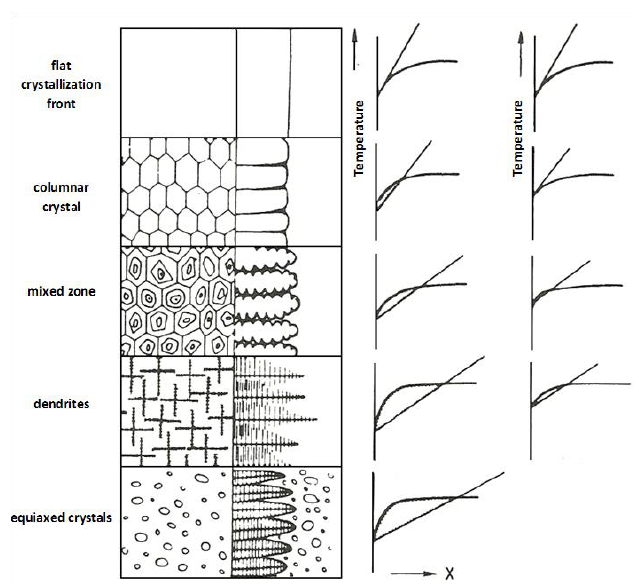
Figure 1. The type of crystals formed, based on the constitutional undercooling, versus distance from the crystallization front (coordinate axis X).